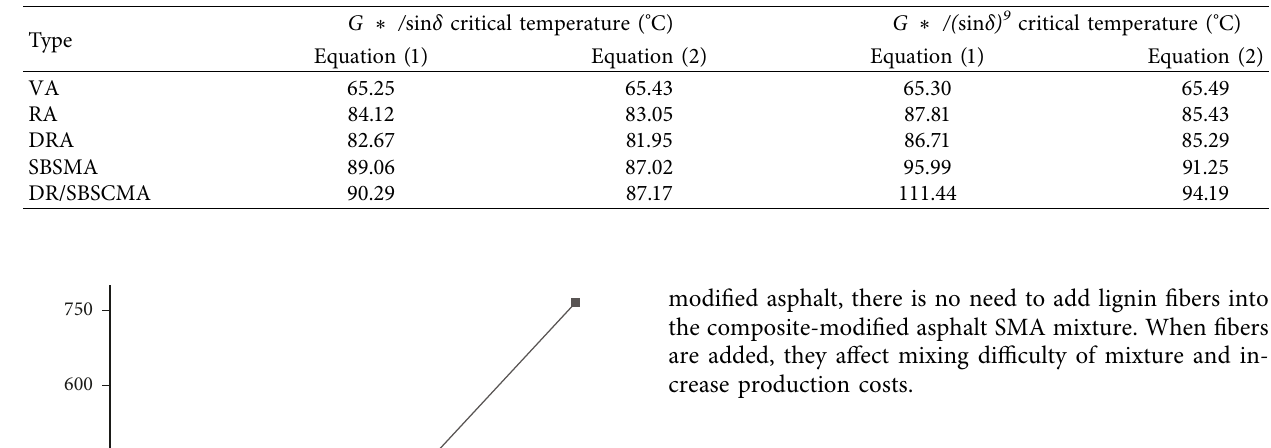
Table 9: Test results of critical temperature.